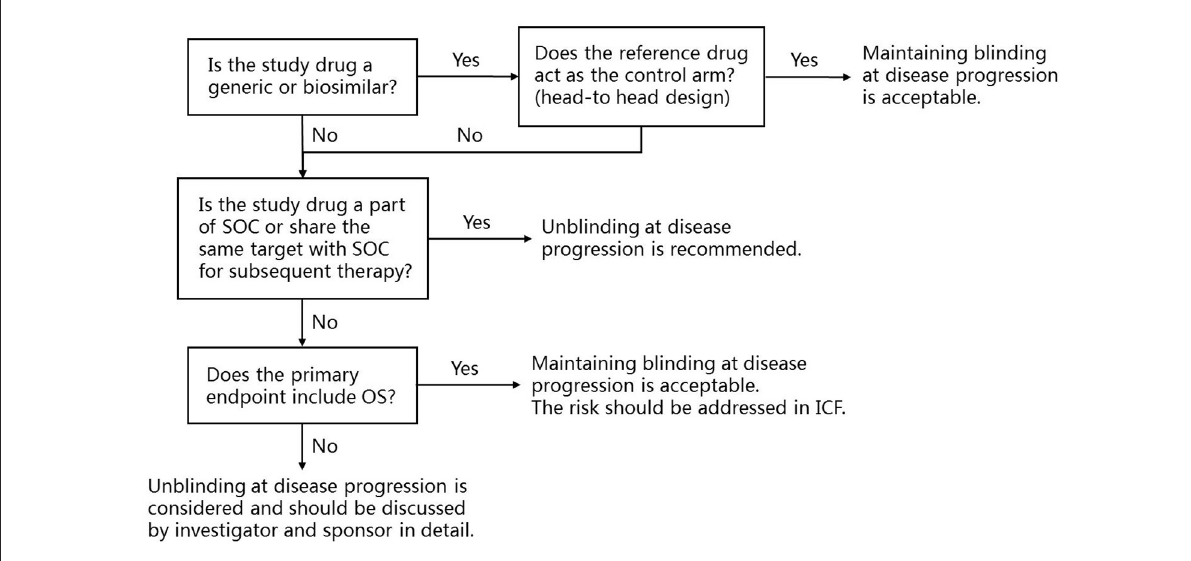
FIGURE1 The framework for the application of unblinding at disease progression at trial level and recommendations. SOC, Standard of care; OS, Overall survival; ICF, Informed consent form.